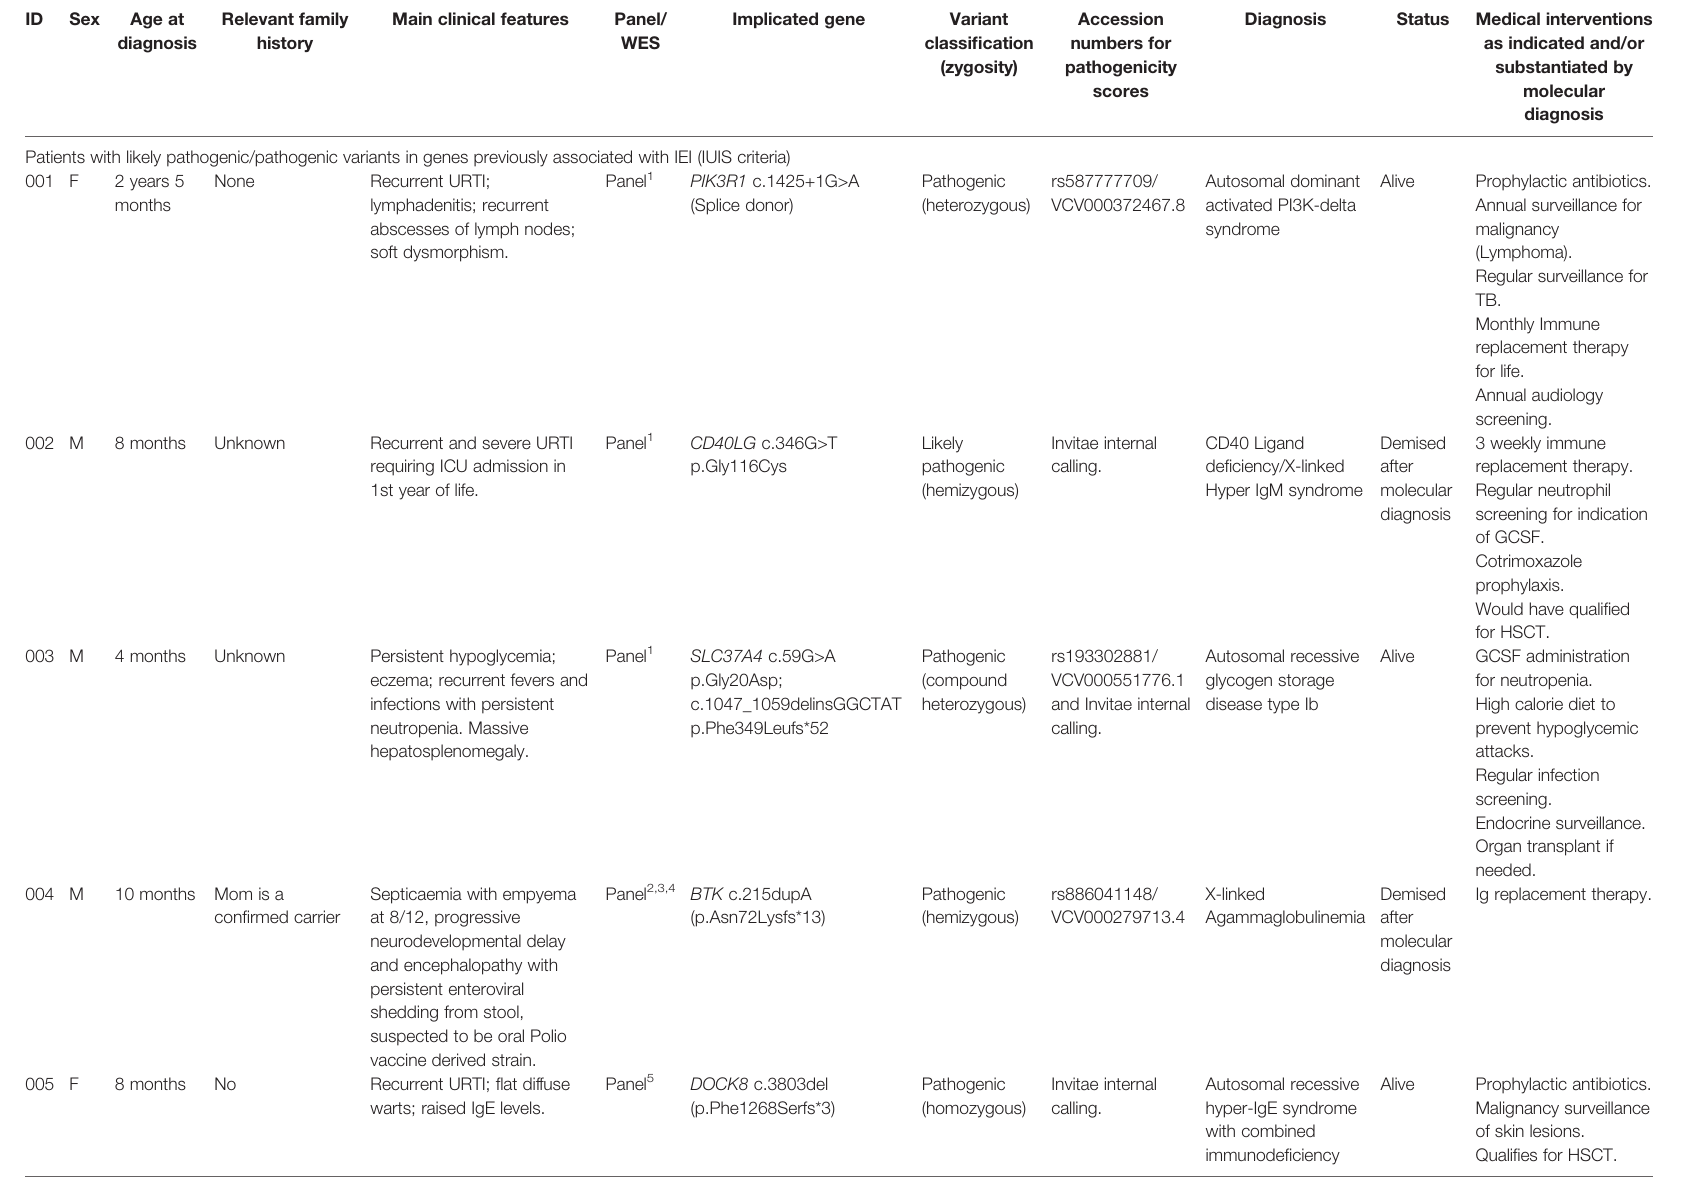
TABLE 2 | Clinical presentation of patients with genes with pathogenic/likely pathogenic